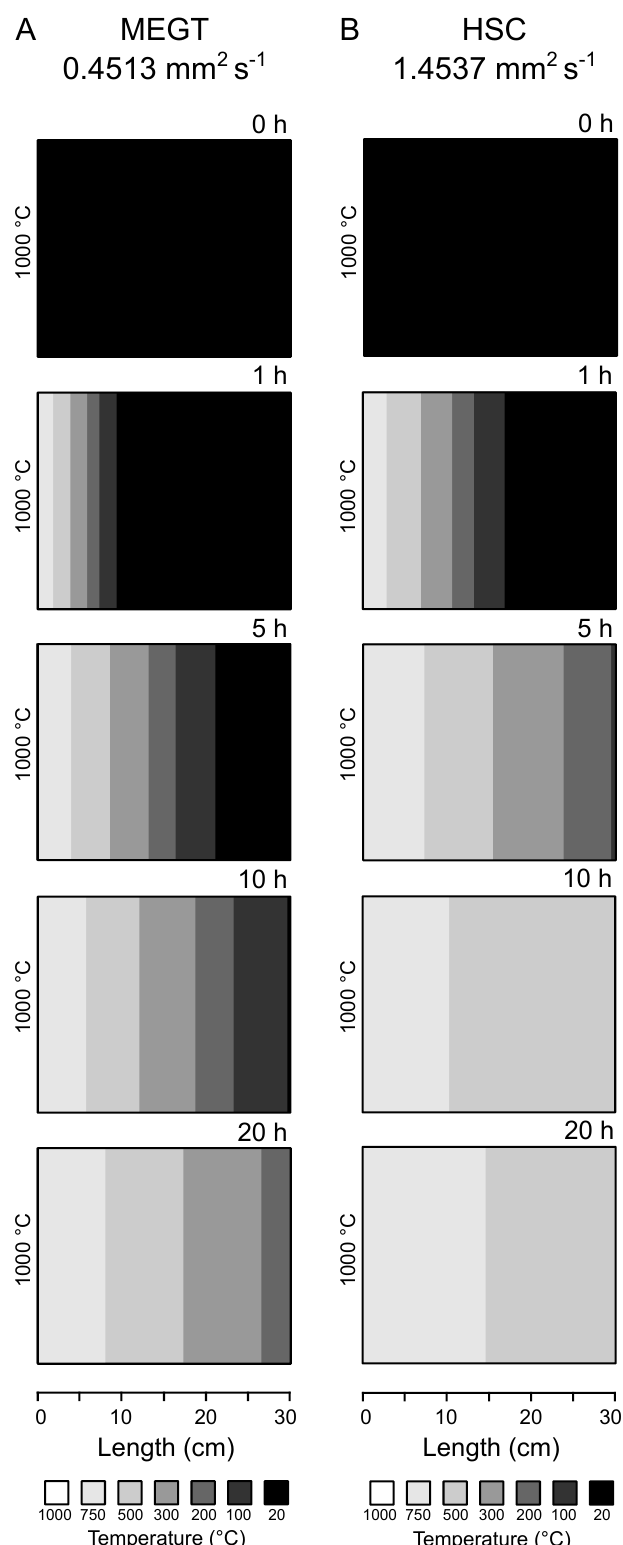
Figure 13: Thermal modelling showing the isotherms within a 300 mm block (represented by the rectangles) of [A] Mt. Epomeo Green Tu ff (MEGT) and [B] high- strength concrete (HSC) for a constant fire temperature of 1000 ◦ C (from the left) after 0, 1, 5, 10, and 20